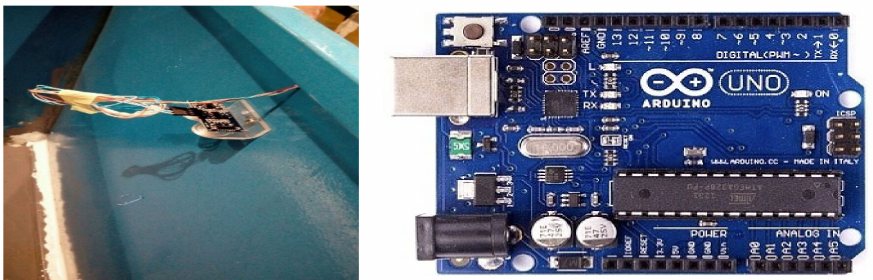
Figure 8. Ultrasonic Sensor HC-SR04 and Arduino Uno Data Logger.